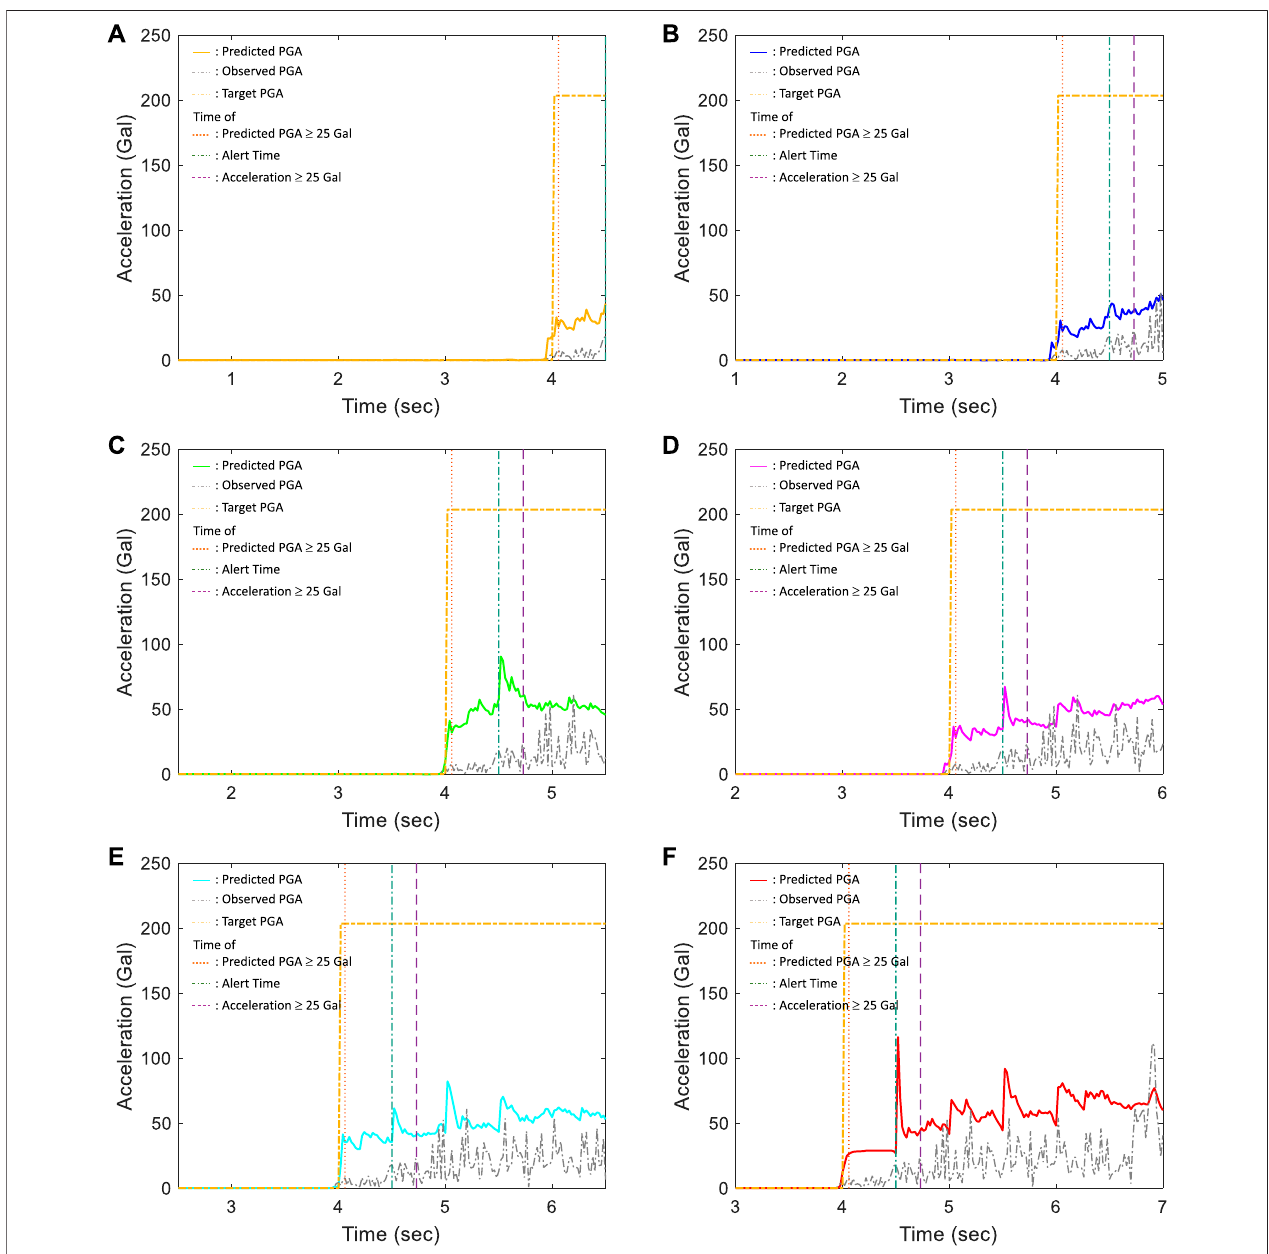
FIGURE7| TheobservedPGAtimehistories,predictedPGAtimehistories,andtargetPGAtimehistoriesofatypicaltruepositive(TP)caseusing (A) t w =0.5 s; (B)